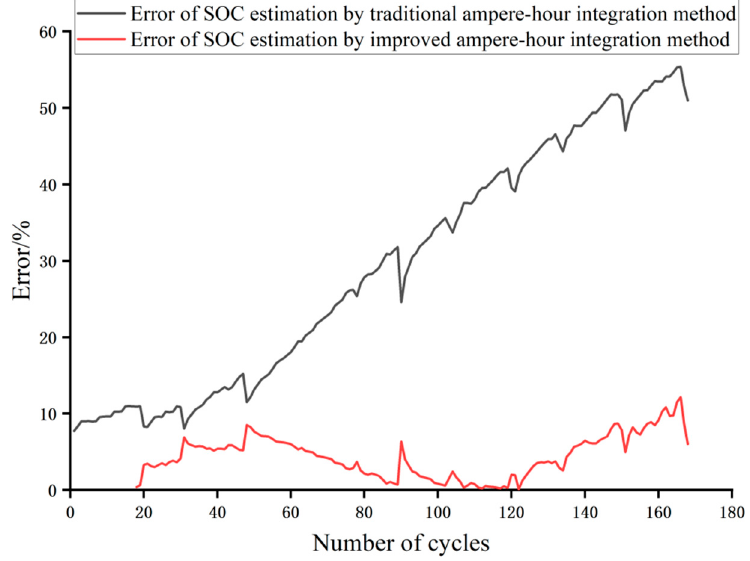
Figure 9. Error curve of SOC estimation for each cycle of the No.5 battery.